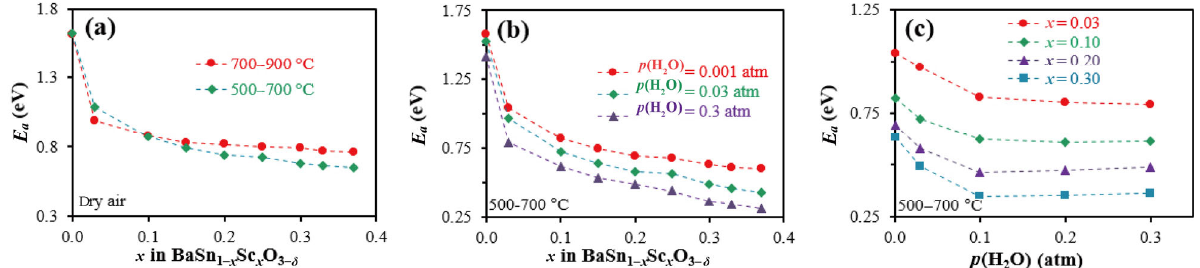
Fig. 4 E a for the BaSn 1 − x Sc x O 3 − δ materials in oxidizing conditions: (a) concentration dependencies for low- and high-temperature ranges; (b) concentration dependencies at different humidification levels; and (c) p (H 2 O) dependencies for various dopant x .